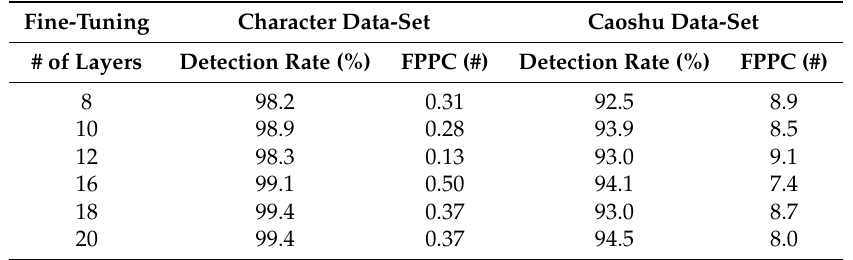
Table 3. Performance comparison based on the number of layers when using a pre-trained network.